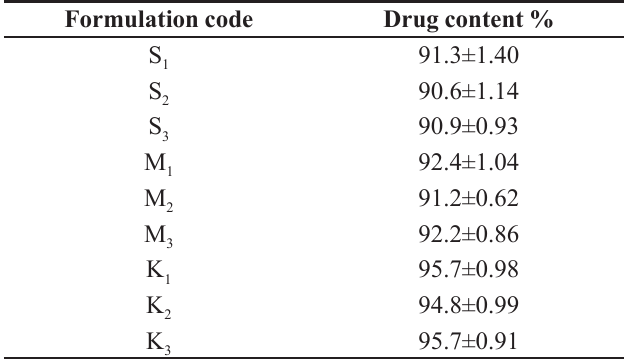
TABLE III - Drug content of the various solid dispersions